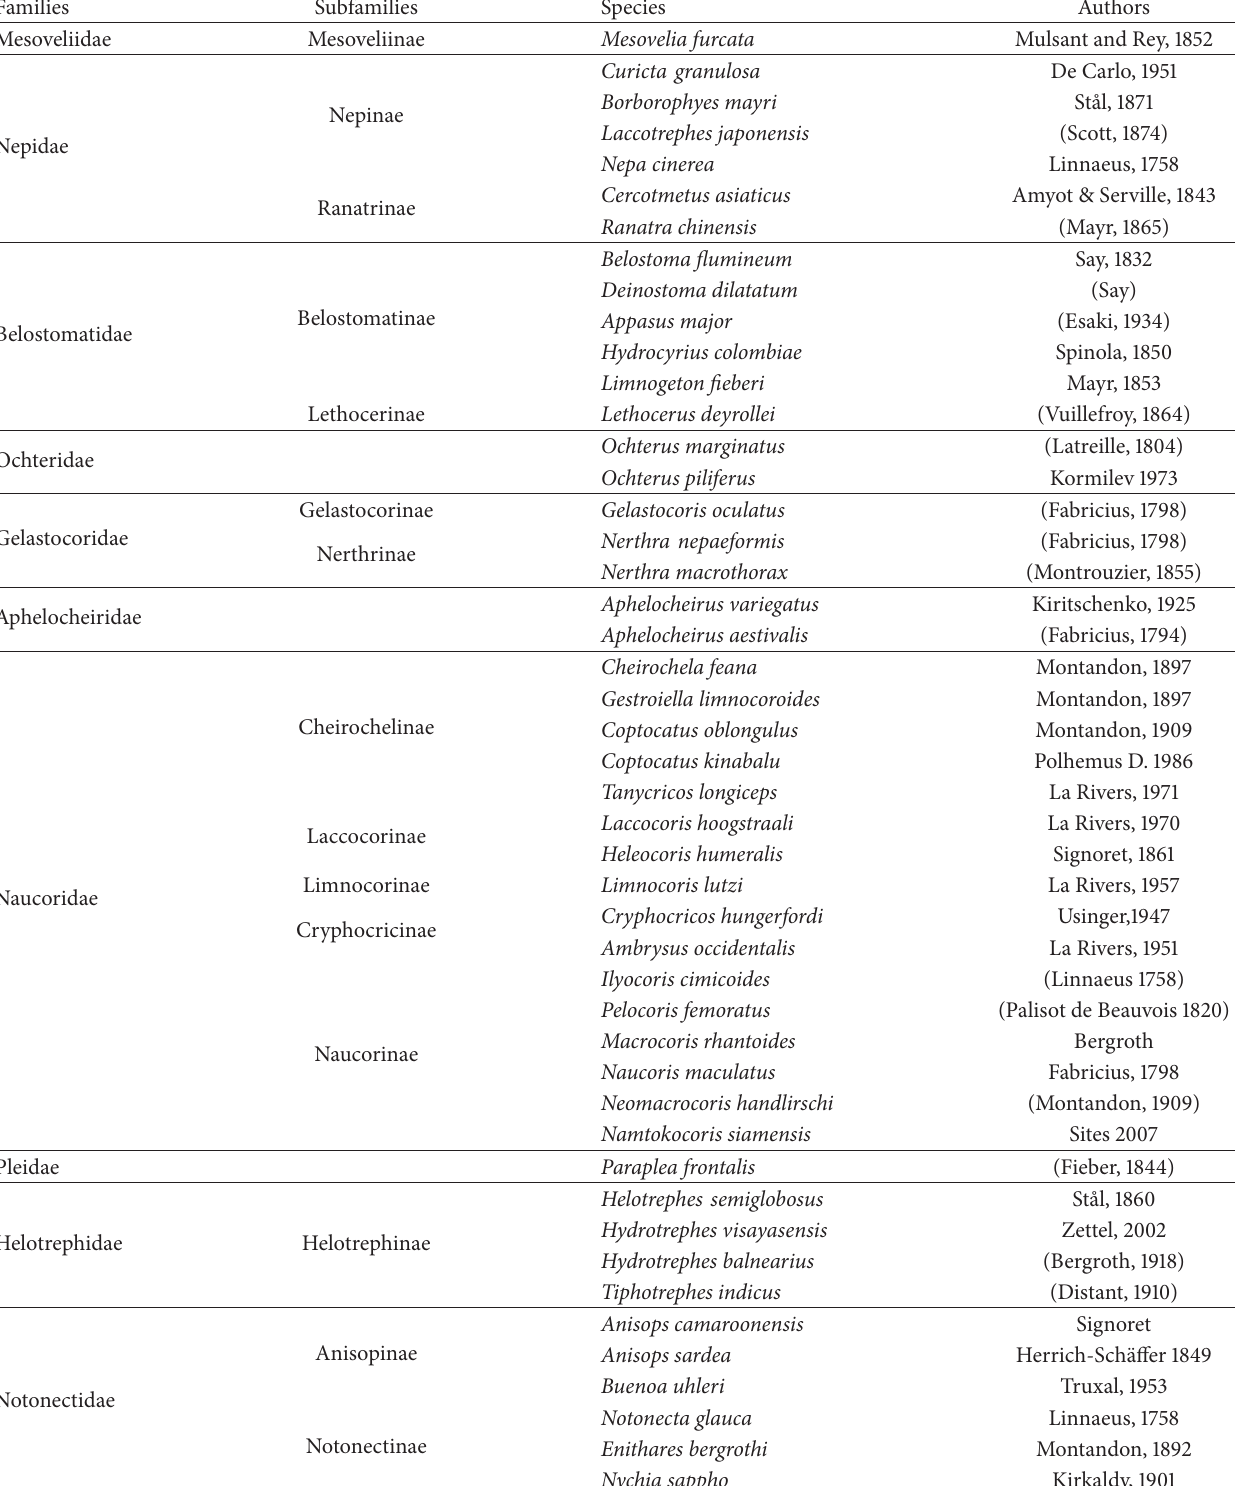
Table 1: The list of fifty-six nepomorphan species which have been studied. Additionally, one species of the outgroup (Gerromorpha: Mesoveliidae: Mesovelia furcata ) has been